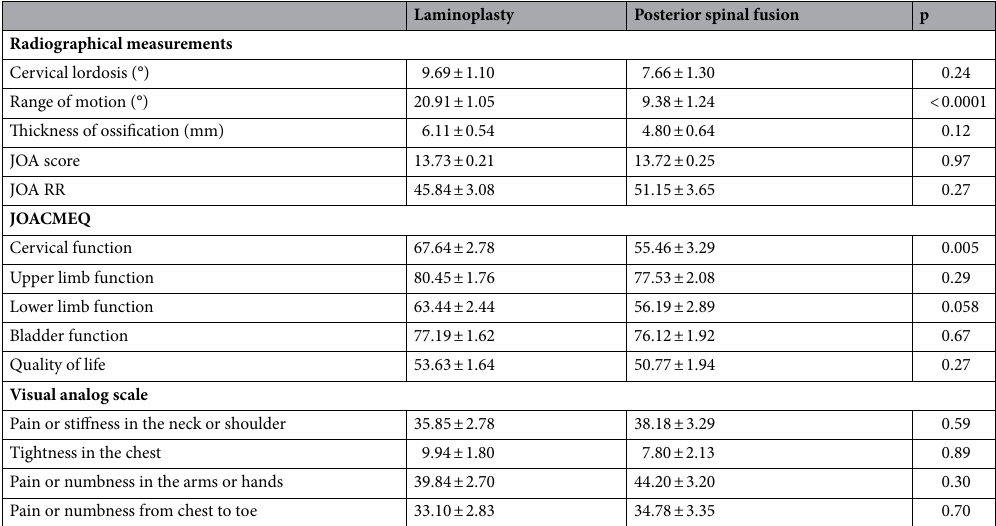
Table 4. Two years postoperative radiographical parameters and quality of life in the weighted sample of patients undergoing laminoplasty or posterior spinal fusion. Values are means and standard - error. Values are weighted for IPTW and further adjusted for baseline age, sex, VAS (pain or numbness in the arms or hands), preoperative CMEQ (bladder function), preoperative comorbidity (cerebrovascular disease). JOA Japanese Orthopaedic Association, JOACMEQ Japanese Orthopaedic Association Cervical Myelopathy Evaluation Questionnaire, IPTW inverse probability of treated weighting, VAS visual analogue